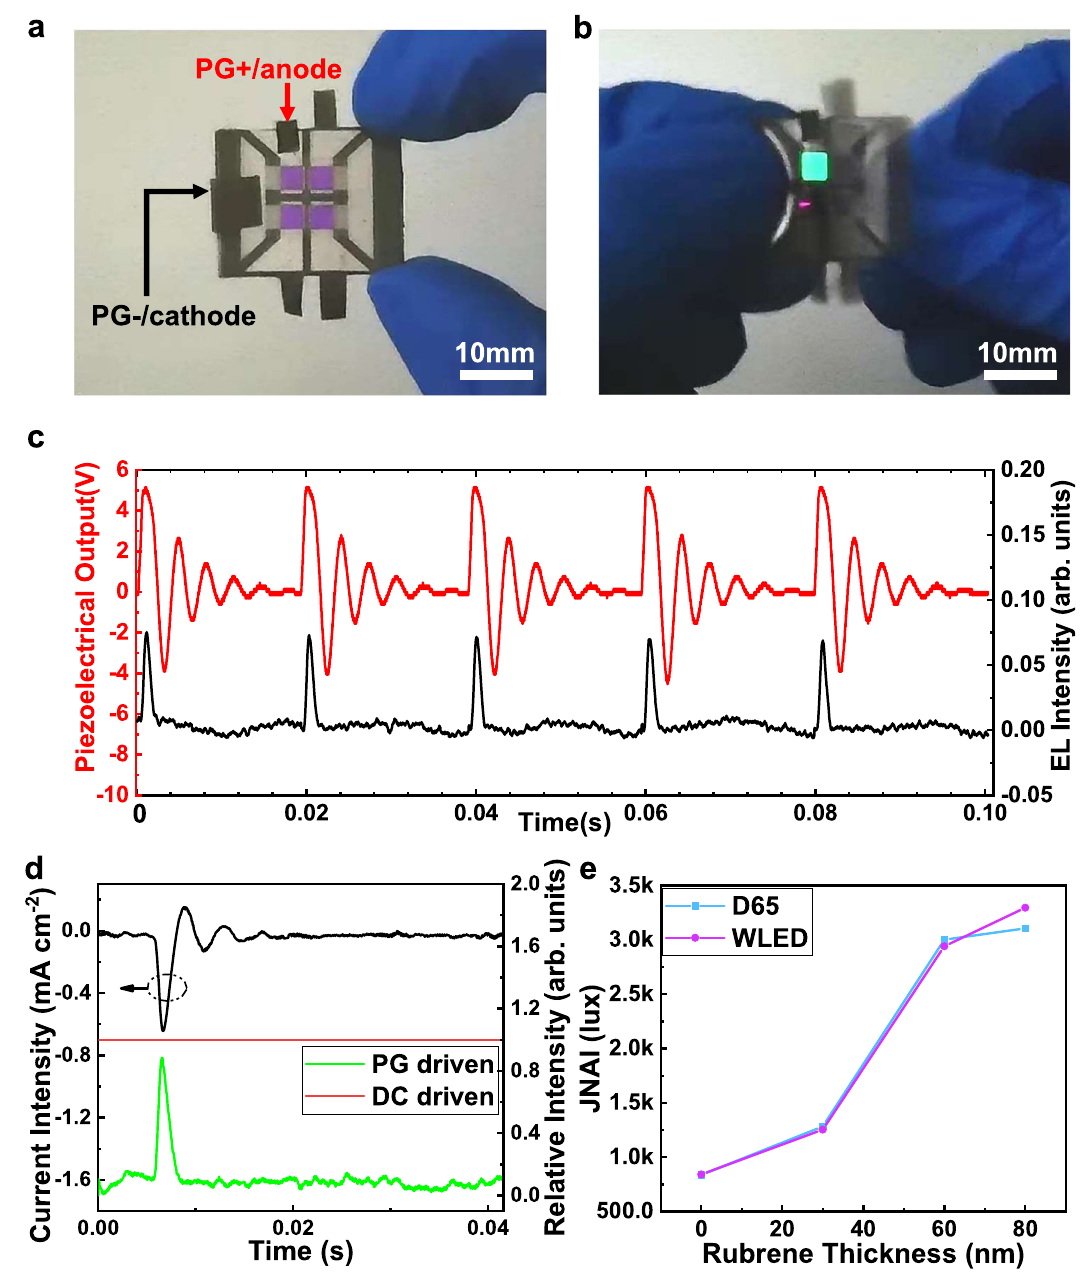
Fig. 4 | Characteristics of fl exible mechanoluminophore device. a Schematic diagramofPGelectrodeconnectiontoTEOLED,wherePG+andPG − refertothePG positiveandnegativeelectrodes,respectively. b ApictureoftheTEOLEDlightpulse generation when PG is actuated. c Piezoelectric output voltage and normalized photoelectricsignalformultiplecycles. d Upperblackcurve:Thecurrentdensityof